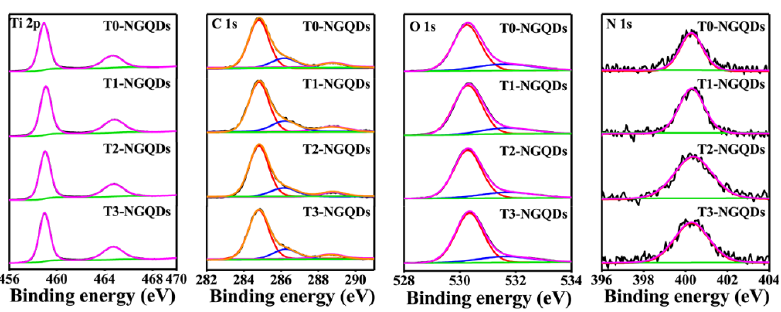
Figure 2. XPS spectra of different TiO 2 /NGQDs composites. Table 2. Percentages of different bonds according to the fitting results of the XPS high-resolution spectra calculated from Figure 2.